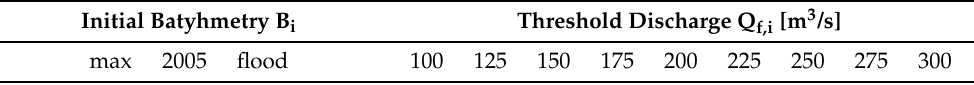
Figure 4. Longitudinal section of the mean river bed for the three different initial bathymetries B. Table 3. Overview of the numerical configurations to obtain the